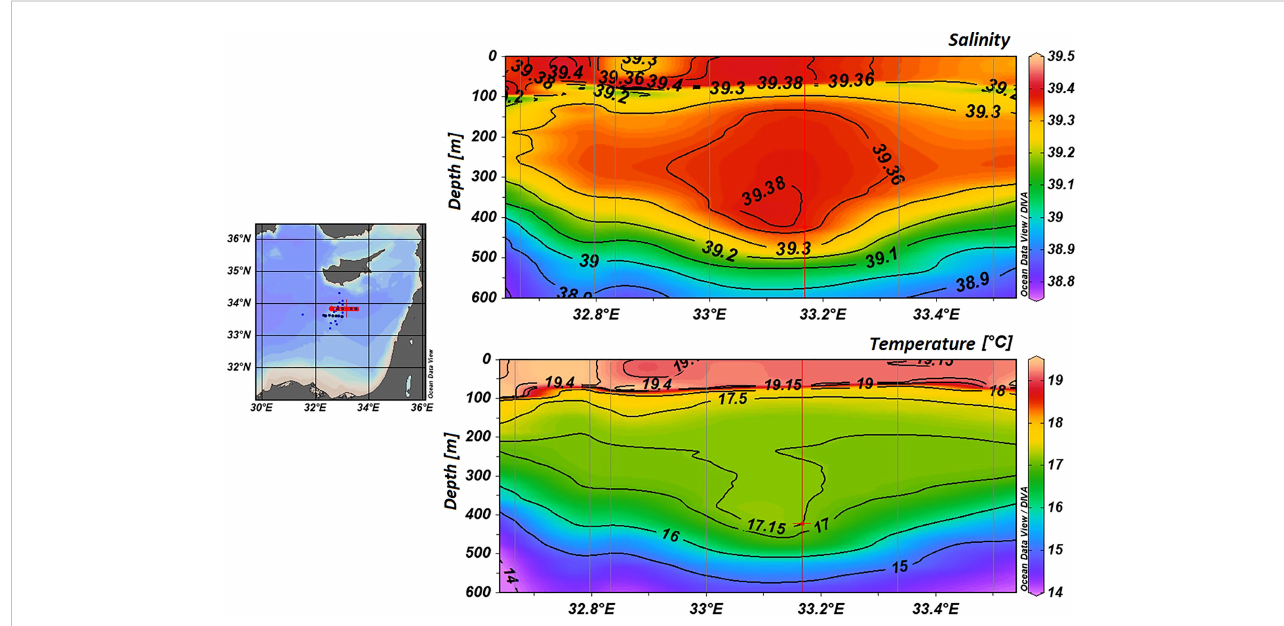
FIGURE 10 West-East salinity and temperature cross sections during the MSM 14-1 cruise, Dec 2009-Jan 2010, in the vicinity of the Eratosthenes